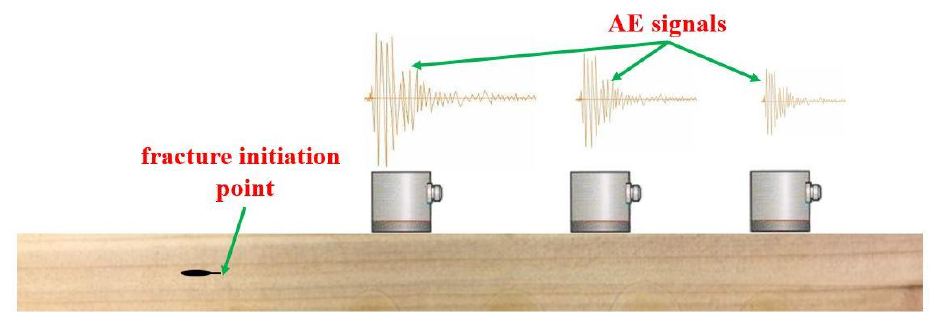
Figure 1. Attenuation of acoustic emission signals during propagation.